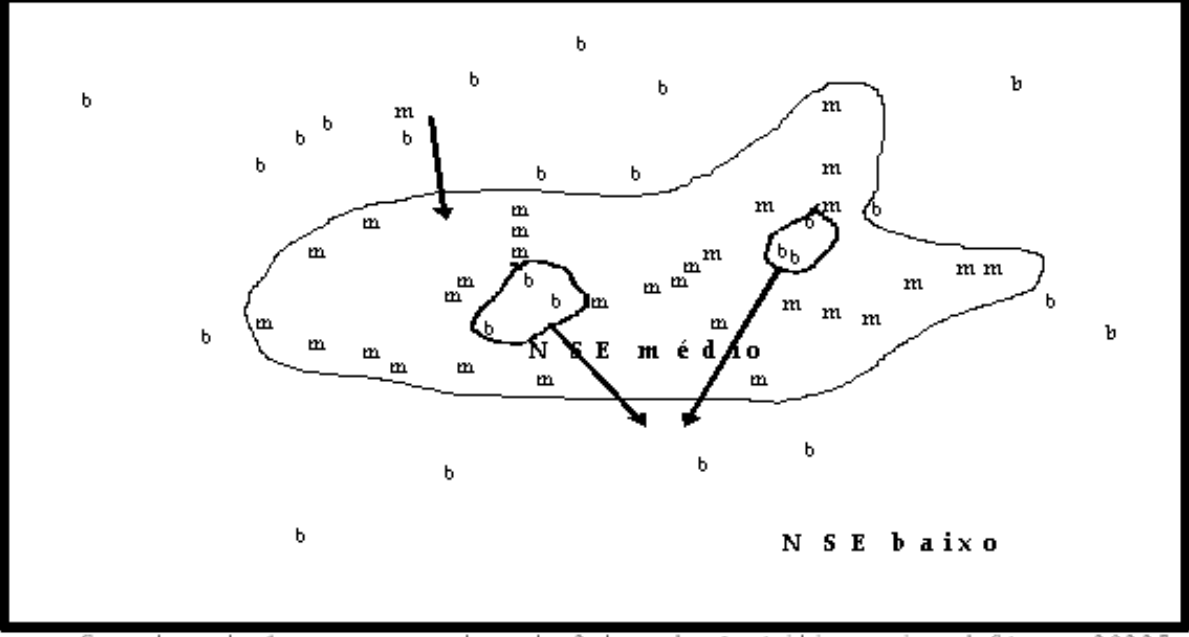
Figura 6 . Análise SSA comparativa entre os grupos NSE baixo e NSE médio a partir dos perfis relativos às ordenações das ocupações em função da